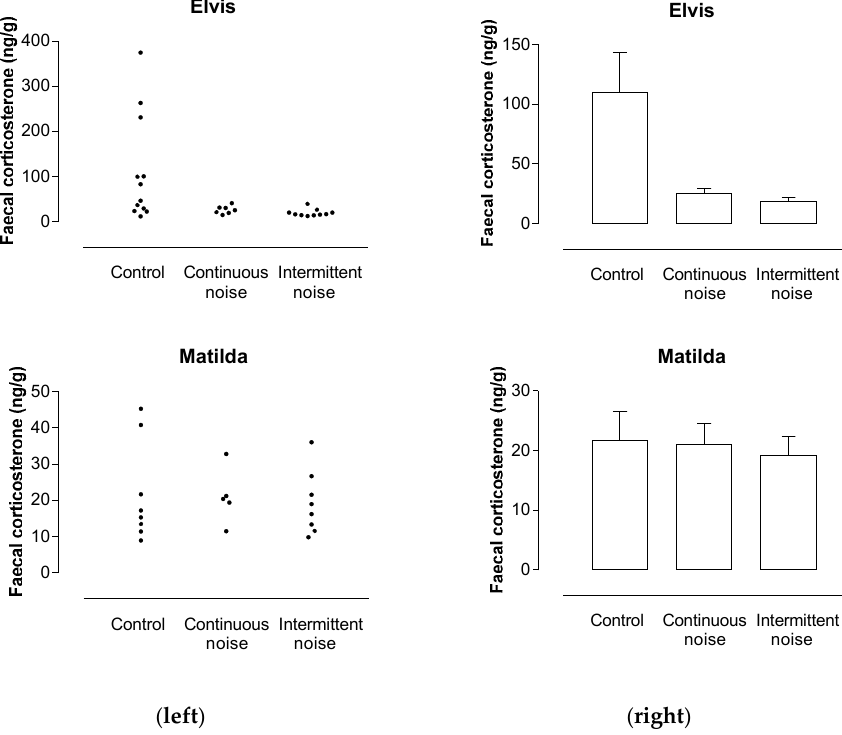
Figure 10. Fecal corticosterone metabolite concentrations in individual samples ( left ) and mean fecal